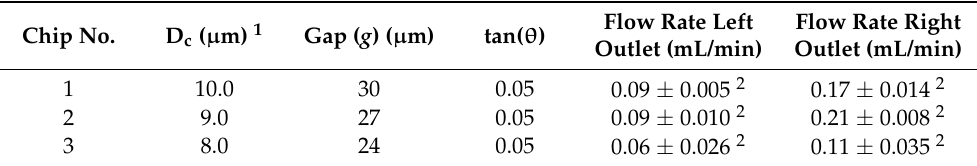
Table 1. Summary of the microstructures of the deterministic lateral displacement (DLD) microdevices in this